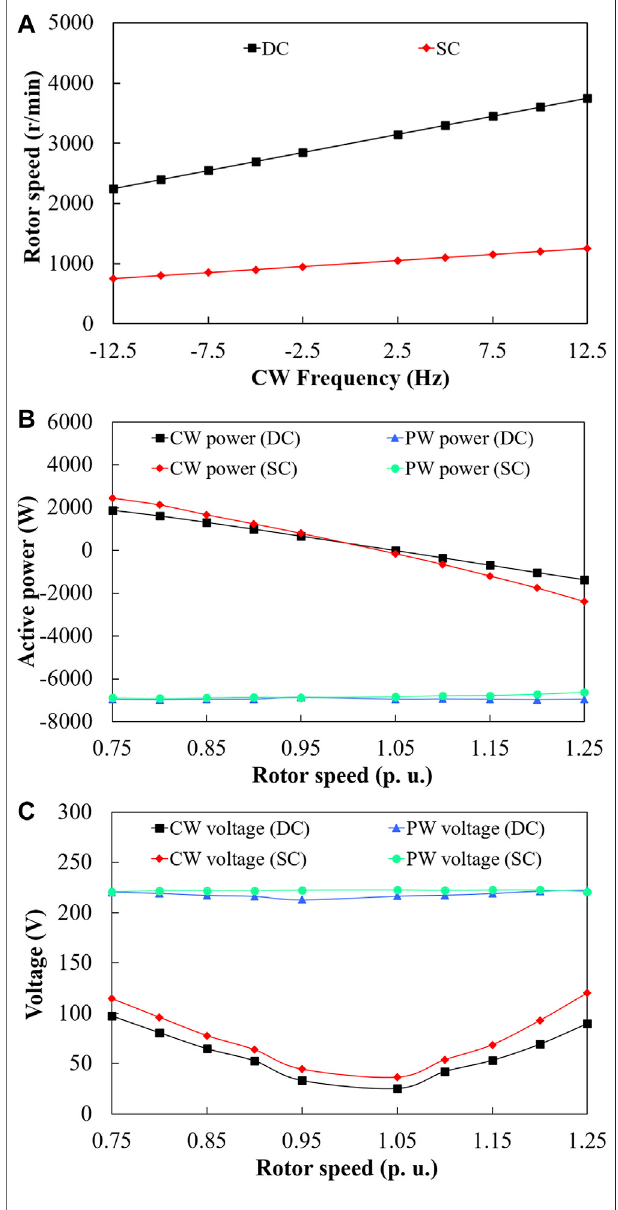
FIGURE 6 | Comparisons of rotor speed, active power, and voltage for DC and SC modes (A) Rotor speeds versus CW frequency (B) CW and PW active powers versus rotor speed (C) CW and PW voltages versus rotor